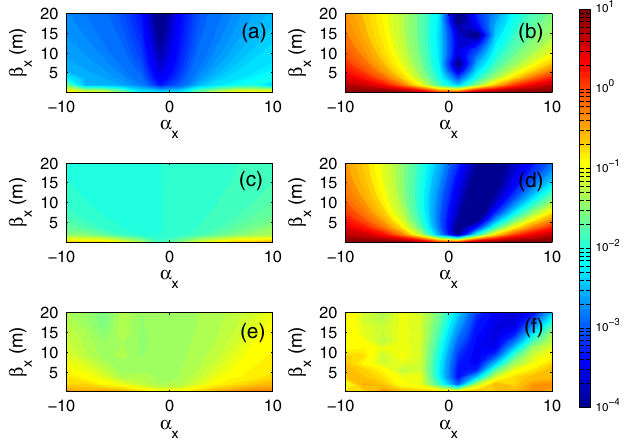
FIG. 4. Fractional horizontal (left column) and longitudinal (right column) emittance dilutions at the exit of the exchanger beam line versus the incoming horizontal Courant-Snyder beam parameters. The rows correspond to different incoming normal- Þ ¼ ; " n ized emittance partitions from top to bottom ð " n x; 0 z; 0 ð 10 ; 1 Þ , (1,1), and (1,10) (all numbers are in micrometers). The longitudinal phase space parameters used in these calculations ¼ 400 (cid:14) m , and a chirp C ¼ 6 m (cid:1) 1 . are a bunch length (cid:10) z; 0